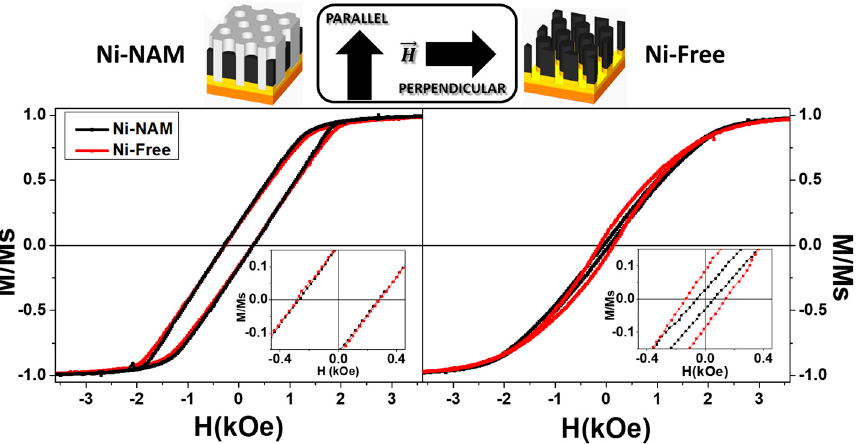
Figure 5. Magnetic hysteresis loops along the parallel ( left ) and perpendicular ( right ) direction of the applied magnetic field respect to NWs axis for Ni-NAM (black) and Ni-Free (red) samples. For reasons of clarity, drawings indicating sample type and direction of the applied magnetic field are also included.